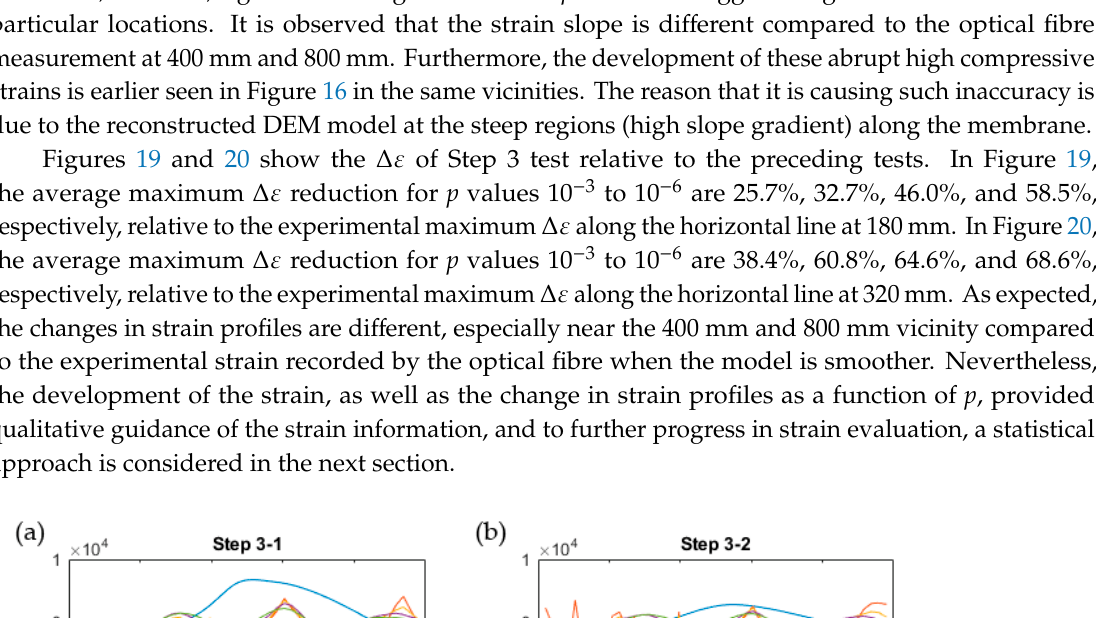
Figure 18. In-plane deformation test Step 3 strain ( a ) at 180 mm and ( b ) 320 mm of optical fibre and different cubic smoothing spline weighting parameter from 10 − 1 to 10 − 6 .